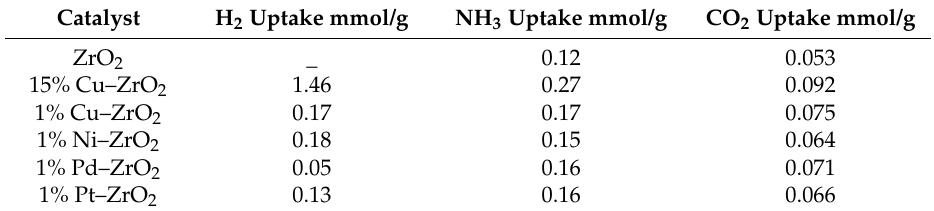
Figure 2. ( a ) H 2 -TPR profiles of pure ZrO 2 and ZrO 2 loaded with different Cu percentages; ( b ) H 2 -TPR profiles of different metals loaded on ZrO 2 . Table 1. Total consumption of H 2 , NH 3 , and CO 2 during the H 2 -TPR, NH 3 -TPD, and CO 2 -TPD experiments for the different